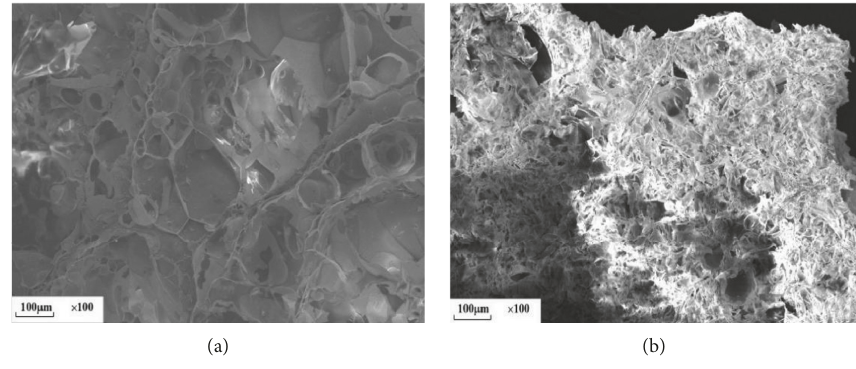
Figure 2: SEM images of EP (a) and OD/EP (b).